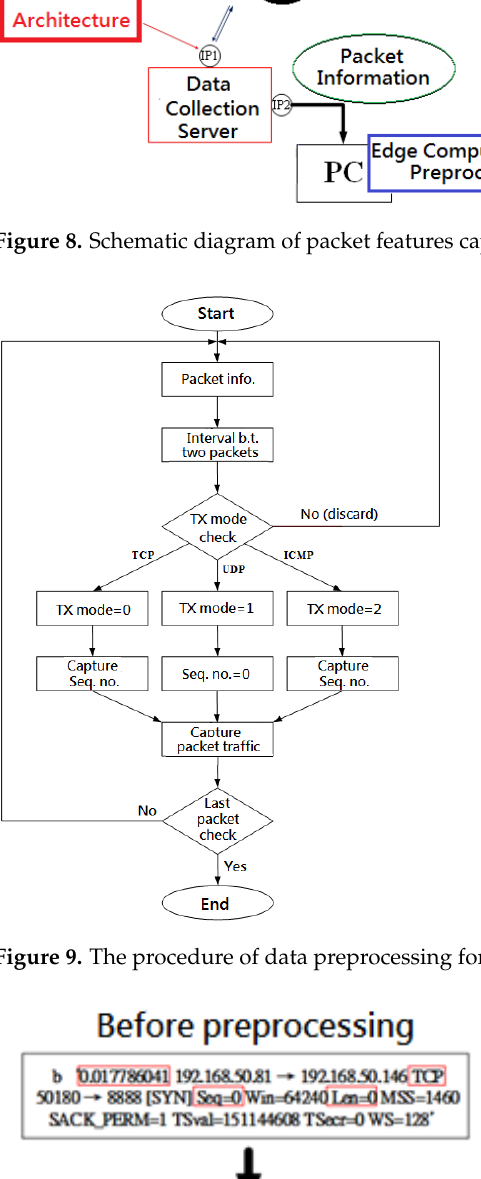
Figure 9. The procedure of data preprocessing for packet features capturing.